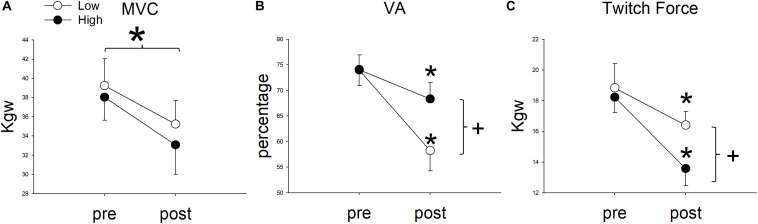
The comparison of (A) maximal voluntary contraction (MVC), (B) voluntary activation (VA), and (C) Twitch Force between pre and post fatigue in cycling exercises of two resistances. *Significant between pre and post fatigue in both resistance cycling exercises (P < 0.05). +Significant between low and relatively high resistance cycling exercise (P < 0.05).